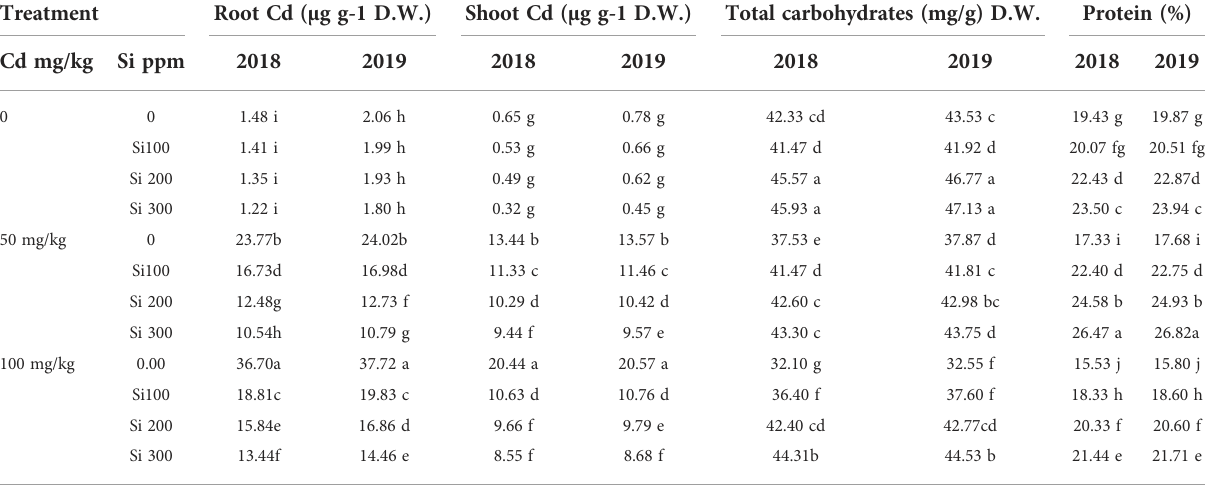
TABLE 5 Effect of foliar application of silicon on pea (Chemical composition of plant organs) grown in different concentrations of cadmium (Cd) during 2018/2019 and 2019/2020 growing seasons. Treatment Root Cd (µg g-1 D.W.)